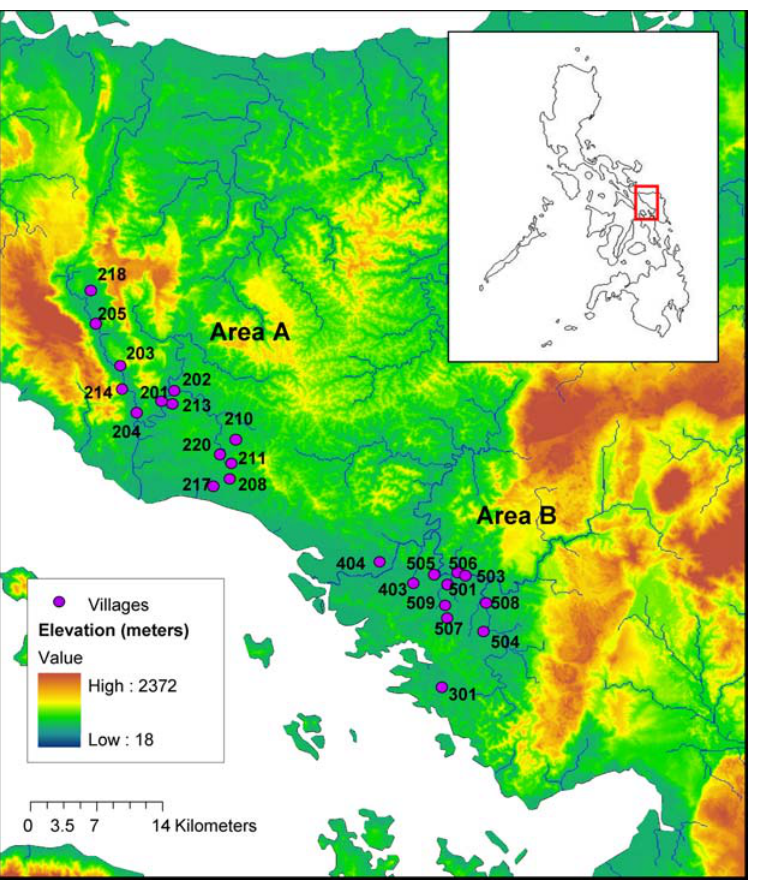
Figure 1. Location of the villages sampled in two geographic areas (A and B) of Samar Province, the Philippines. The inset map shows the location of Samar in the Philippines. Adapted from an original version in Akullian A (2007) Spatial patterns of schistosomiasis: A watershed approach to measuring S. japonicum environmental risk and human and animal disease outcomes [Sc.B. Thesis]. Brown University.